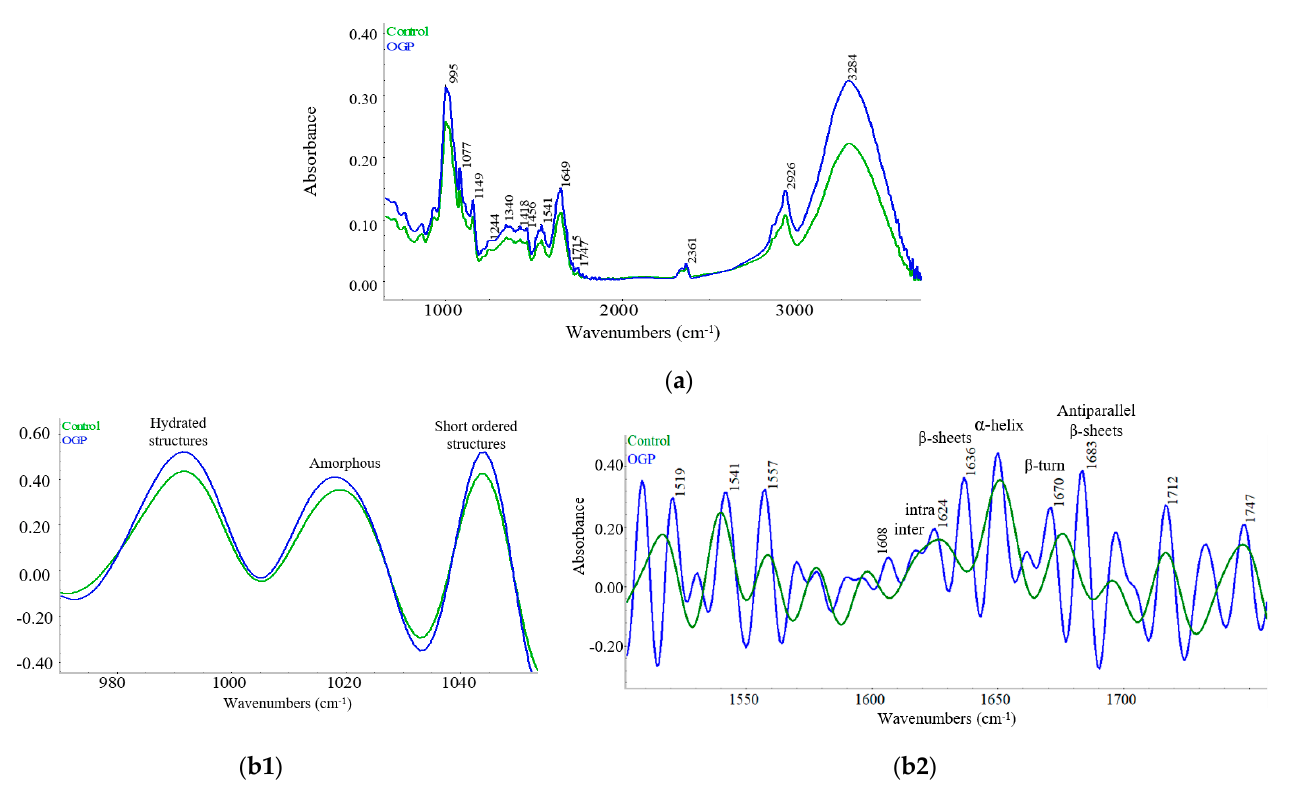
Figure 1. ( a ) Average spectra of optimal wheat-grape peels (OGP) and control samples in mid-infrared region; ( b1 ) starch components’ deconvoluted spectra; ( b2 ) protein and polyphenol components’ deconvoluted spectra. Table 3. Optimal and control product